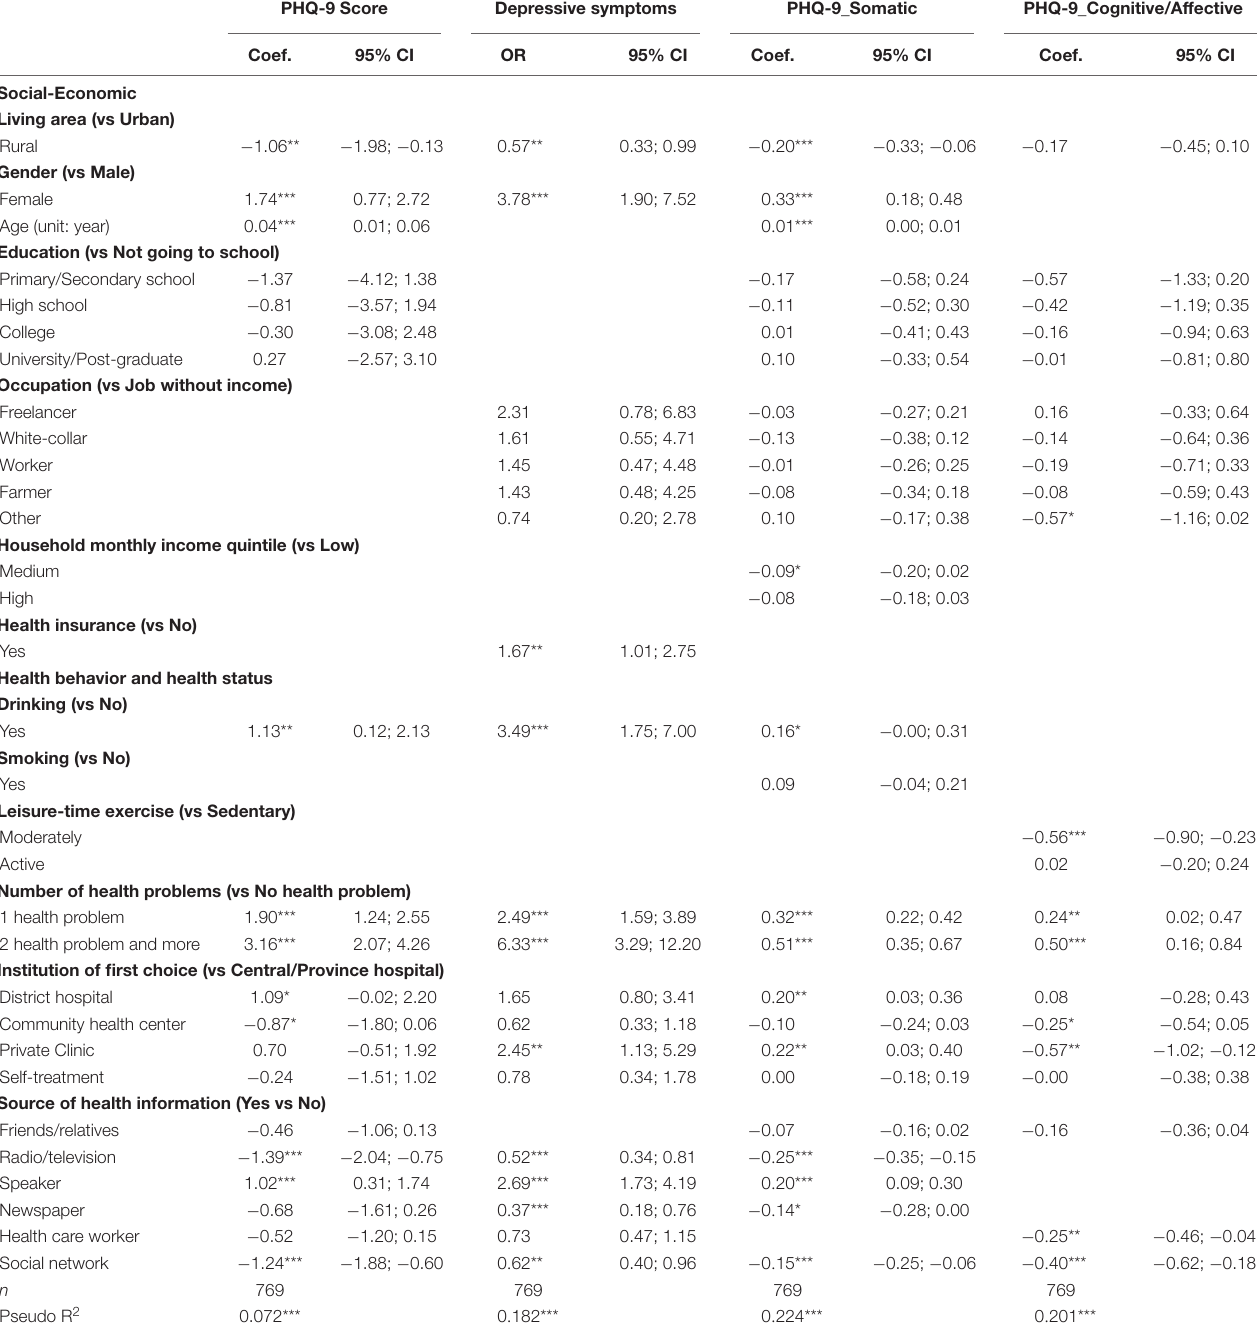
TABLE 6 | Regression results of factors associated with depression among participants. PHQ-9 Score Depressive